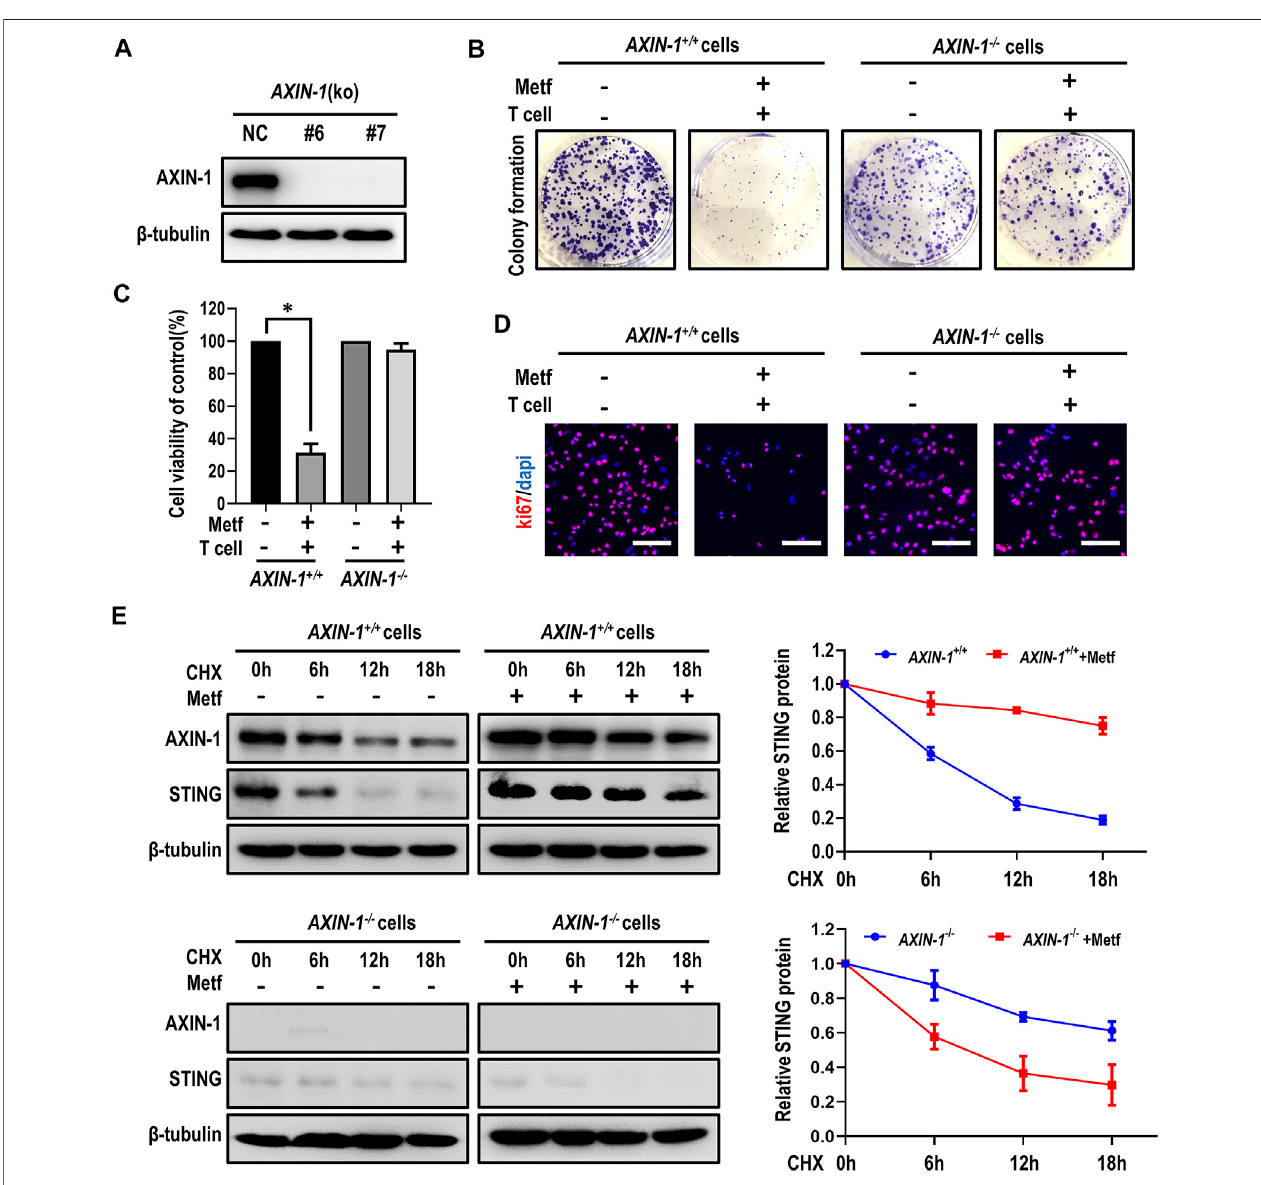
FIGURE4| AXIN-1wasrequired formetformintostabilize STING. (A) ,Celllysatesfrom AXIN-1 knockoutclones ofH460 cellsbyCRISPR/CAS9(KO-6and KO-7) were subjected to western blot. (B) , AXIN-1 +/+ cells and AXIN-1 − / − cells co-cultured with activated T cells (cancer cells to T cells ratio, 1:1) for 48 h with or without metformin were subjected to crystal violet staining. (C) , Cell viability CCK-8 assayfor AXIN-1 +/+ cells and AXIN-1 − / − cells treated asindicated. Data areshown asmean ± SEM. * p < 0.01. (D) , Ki67 incorporation assay on AXIN-1 +/+ cells and AXIN-1 − / − cells treated as indicated. Cells were counterstained with DAPI. (E) , AXIN-1 +/+ cells and AXIN-1 − / − cells were treated with 10 μ M CHX at indicated intervals in the presence of metformin or not. The intensity of STING protein was quanti fi ed using ImageJ software.